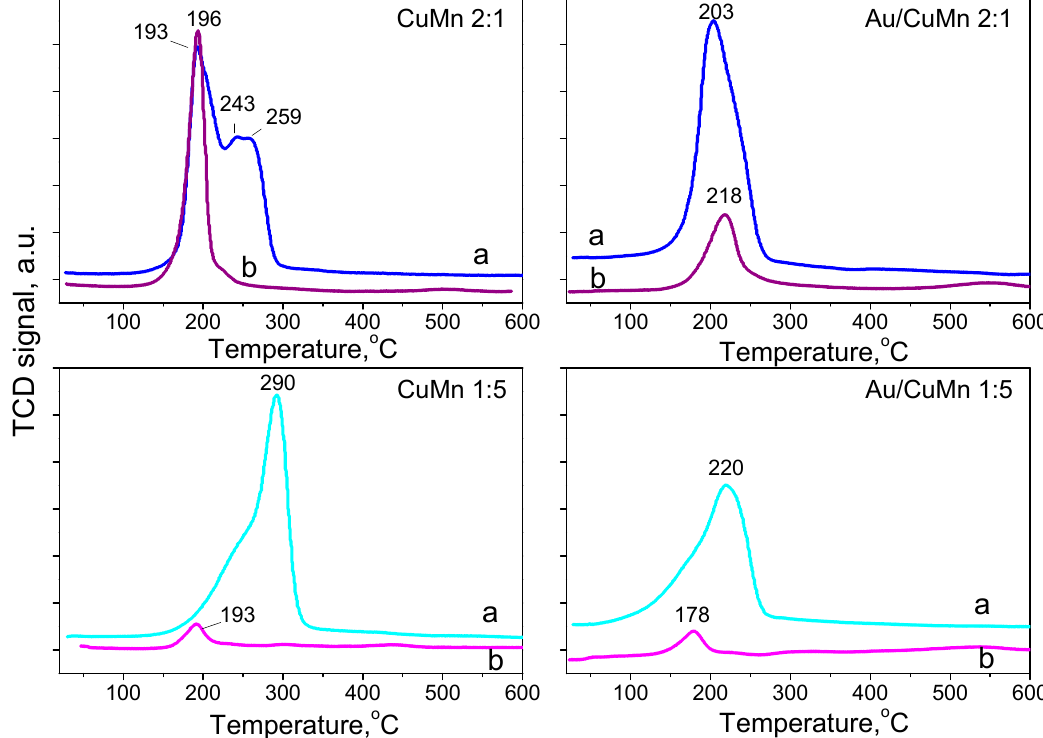
Figure 10. TPR profiles of alumina-supported CuMn and Au/CuMn catalysts with a Cu-to-Mn ratio of 2:1 and 1:5: ( a ) fresh samples; ( b ) samples after the WGS reaction.